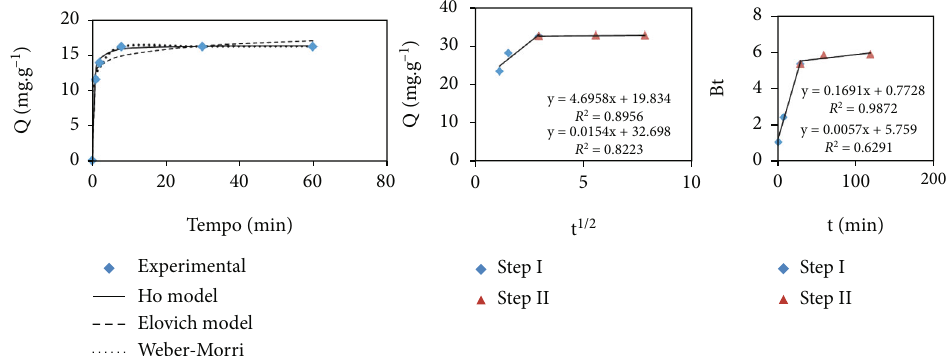
Figure 12: Experimental curves and the Ho, Elovich, and Webber-Morri models of the kinetic study of Pb(II) ion adsorption in ferric Table 6: Numerical results of tests to assess removal percentages of Cu(II), Ni(II), Cd(II), and Pb(II) from combinations clay x electrode. Removal percentage Clay Cu Ni Cd Pb